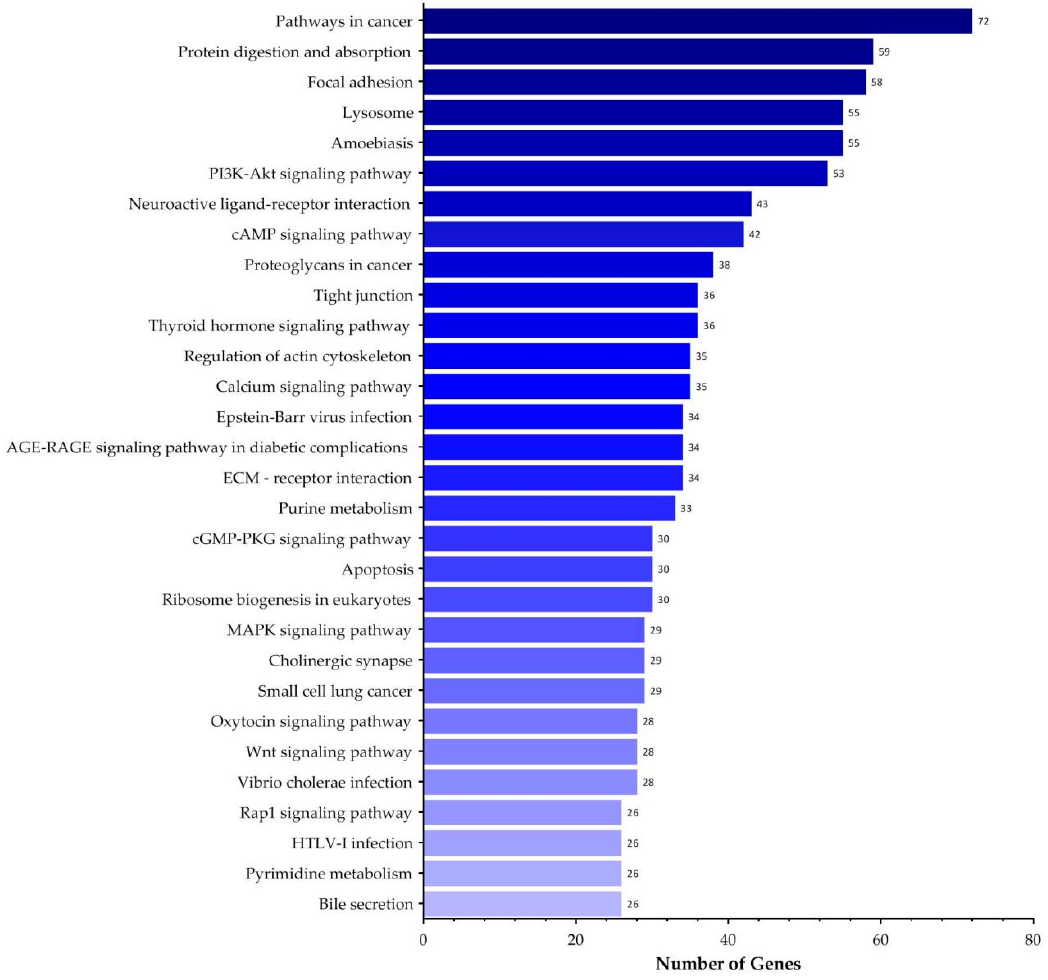
Figure 7. The top 30 pathways of differentially expressed genes of B. xylophilus between aseptic condition and with S. maltophilia .